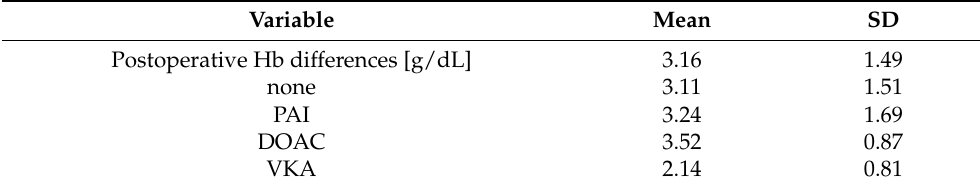
Figure 4. Hb levels at admission depending on anticoagulative medication. PAI: Platelet aggrega- tion inhibitors including acetylsalicylic acid; DOAC: Direct oral anticoagulants; VKA: Vitamin-K- antagonist Warfarin. Table 3. Postoperative Hb differences among patients who did not take RBCT ( n =